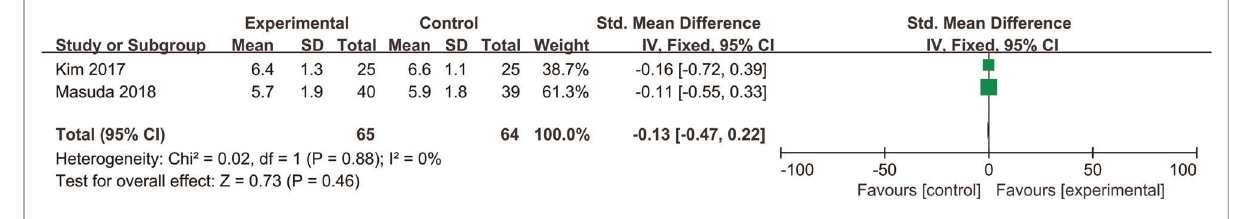
FIGURE 6 Forest pot for Tegner score.